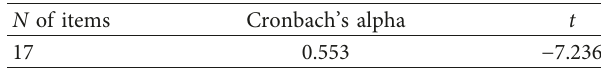
Figure 8: Optimization of learning evaluation. Table 8: Dimensions of the learning strategy table. Table 9: Analysis results of learning strategy questionnaire.